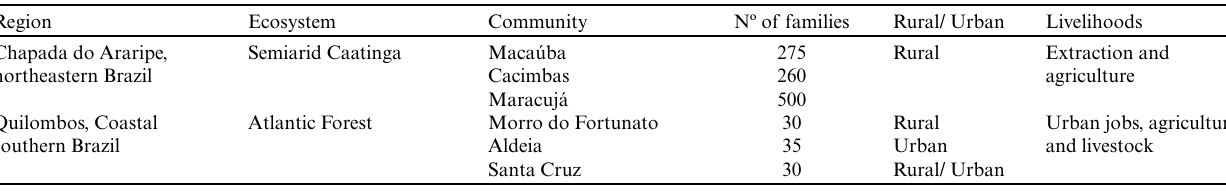
Table 1 . Social and environmental data of the studied communities.